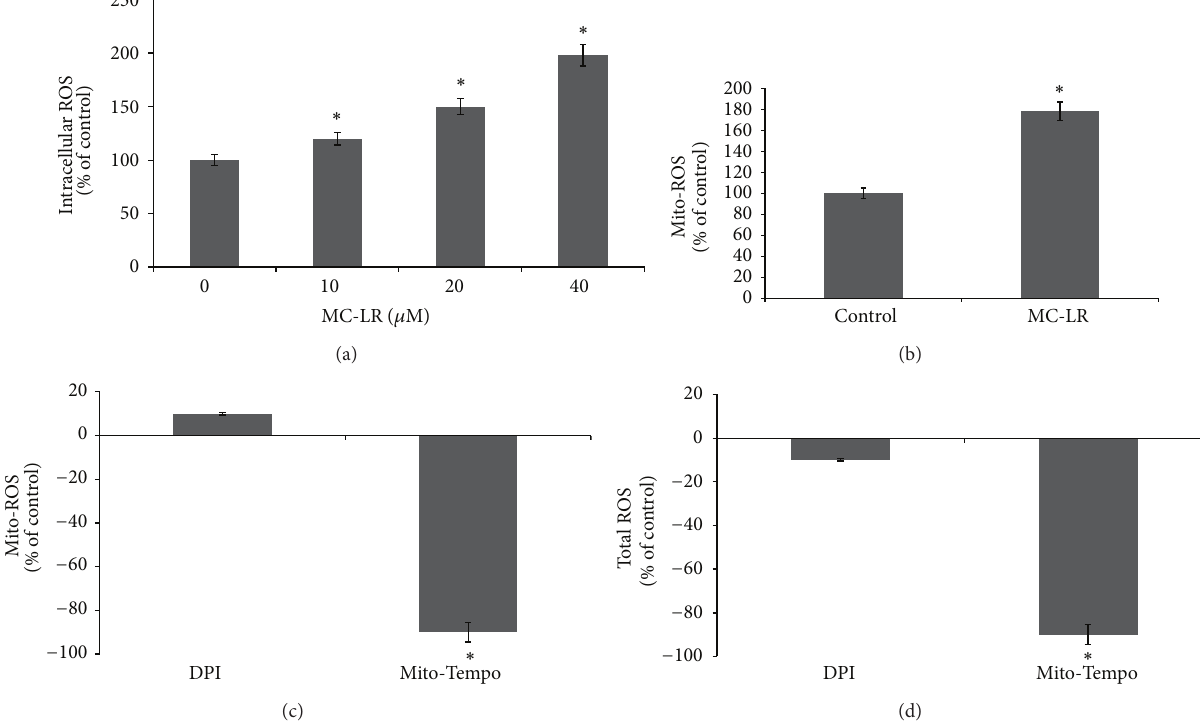
Figure 5: The MC-LR induced ROS expression on HUVECs was detected by DCFH-DA probe assay (a). The mitochondrial ROS in the control and MC-LR treated groups were measured by the DCFH-DA probe (b). The mean change of mitochondrial ROS (c) and total ROS (d) in MC-LR exposure HUVECs treated with DPI or Mito-Tempo. Representative microphotographs are shown. ∗ 𝑝 < 0.05 versus control ( 𝑛 = 3 independent experiments).